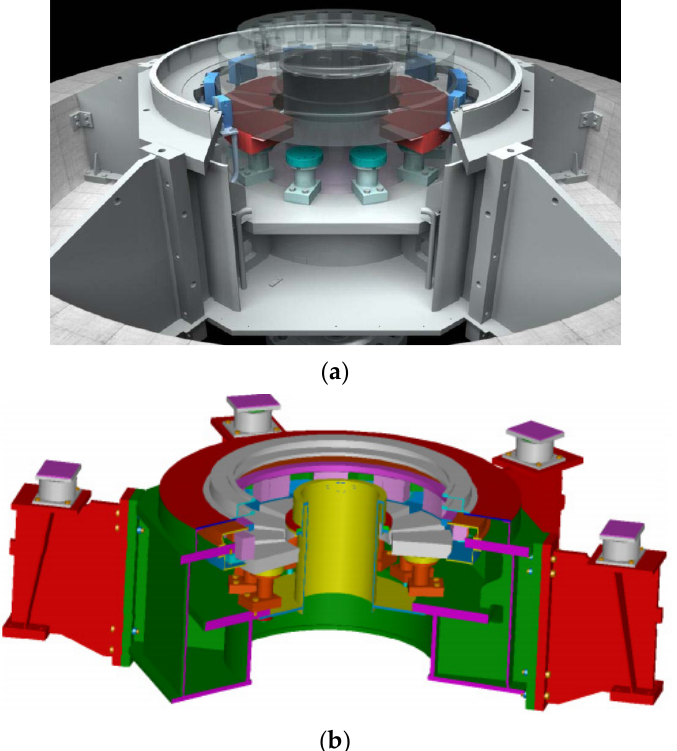
Figure 7. Three-dimensional model of the thrust bearing and combination bearing. ( a ) Three-dimensional model of the thrust bearing for a pumped storage station [113]; ( b ) three-dimensional model of combined bearing [13].